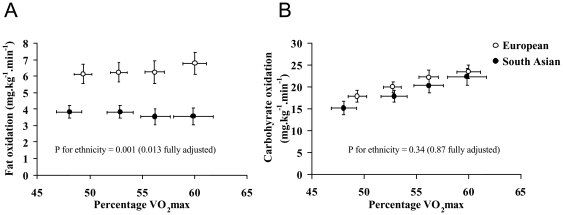
Fat oxidation (A) and carbohydrate oxidation (B) during incremental submaximal exercise.Intensity expressed relative to each individual's maximal oxygen uptake (i.e. percentage VO2max). P values shown are for the main-effect difference between European and South Asian groups, either unadjusted, or adjusted for age, BMI and fat mass.